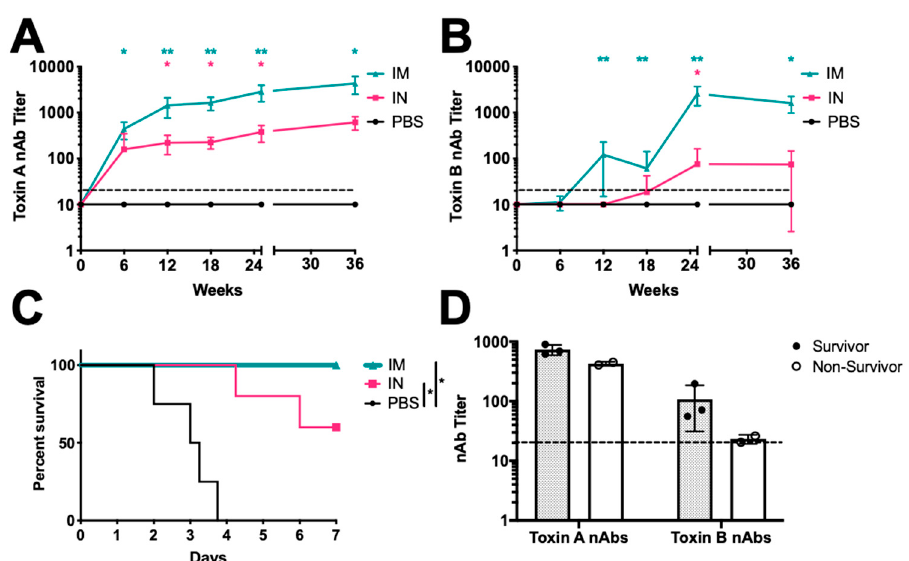
Figure 4. SC-Ad6-TcdA / B provides protection against lethal spore challenge 45 weeks after single immunization. Female Syrian hamsters (n = 10) were vaccinated i.n. or i.m. with 1 × 10 11 virus particles of SC-Ad6-TcdA / B, or i.n. with PBS. Serum collected at weeks 6, 12, 18, 25, and 36 weeks after immunization were assayed to determine mean neutralizing titers for ( A ) toxin A and ( B ) toxin B. In both panels, points show the mean titer, bars show standard deviation, and the dotted line indicates the limit of detection (*Adjusted p < 0.05 compared to control, **Adjusted p < 0.05 compared to control and i.n. route). X -axis break represents the termination of the low-dose challenge study; serum collected at week 36 from remaining animals in each group (n = 5). ( C ) Survival curve for i.n. (n = 5) and i.m. (n = 4) SC-Ad-TcdA / B vaccinated animals challenged with UK1 spores 45 weeks after single immunization shows significant protection compared to PBS control animals (n = 4) (* p < 0.01). ( D ) Week 36 neutralizing toxin A and toxin B neutralizing titers of i.n. immunized animals that survived the challenge compared to non-survivors. Columns show the mean titer, bars show standard deviation, and the dotted line indicates the limit of detection.